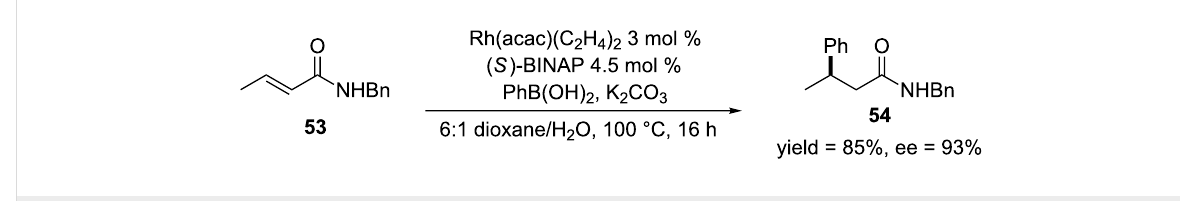
Scheme 14: Rhodium-catalyzed asymmetric 1,4-arylation of an α , β -unsaturated